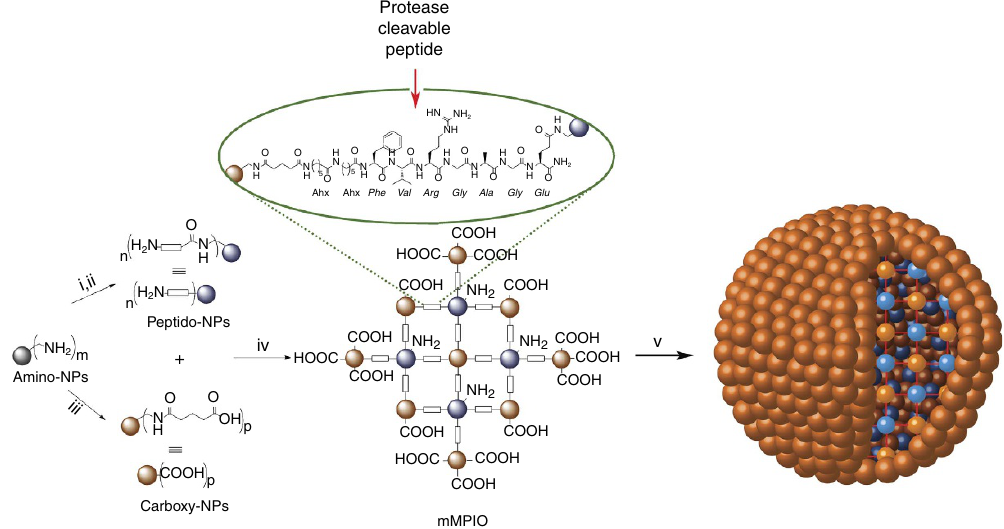
Figure 2 | Schematic representation of the synthesis of mMPIO. Grey spheres represent amine-functionalized dextran-coated iron oxide nanoparticles, blue spheres represent peptido-NPs and brown spheres represent carboxy-NPs. Conditions: (i) peptide 3 , N -(3-dimethylaminopropyl)- N 0 -ethylcarbodiimide hydrochloride (EDC) N -hydroxysuccinimide (NHS), 2-( N -morpholino)ethanesulfonic acid (MES) buffer (0.1M pH6.0)/dimethylsulfoxide (DMSO)